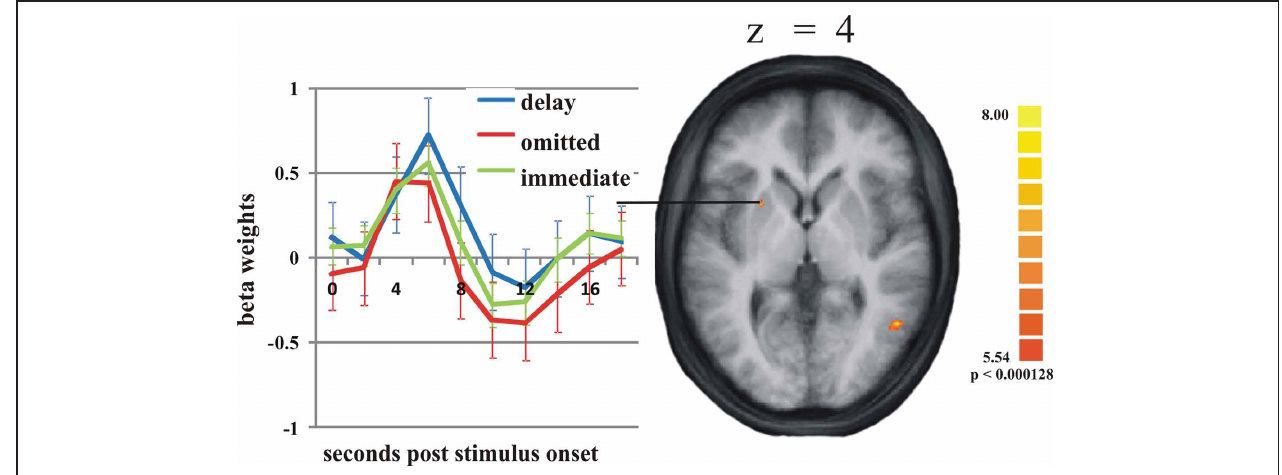
FIGURE 1 | Activation differences in the putamen. On the right: the activation cluster of the putamen in the whole brain analysis comparing delayed and omitted feedback ( q = 0 . 05). On the left: the time course of the